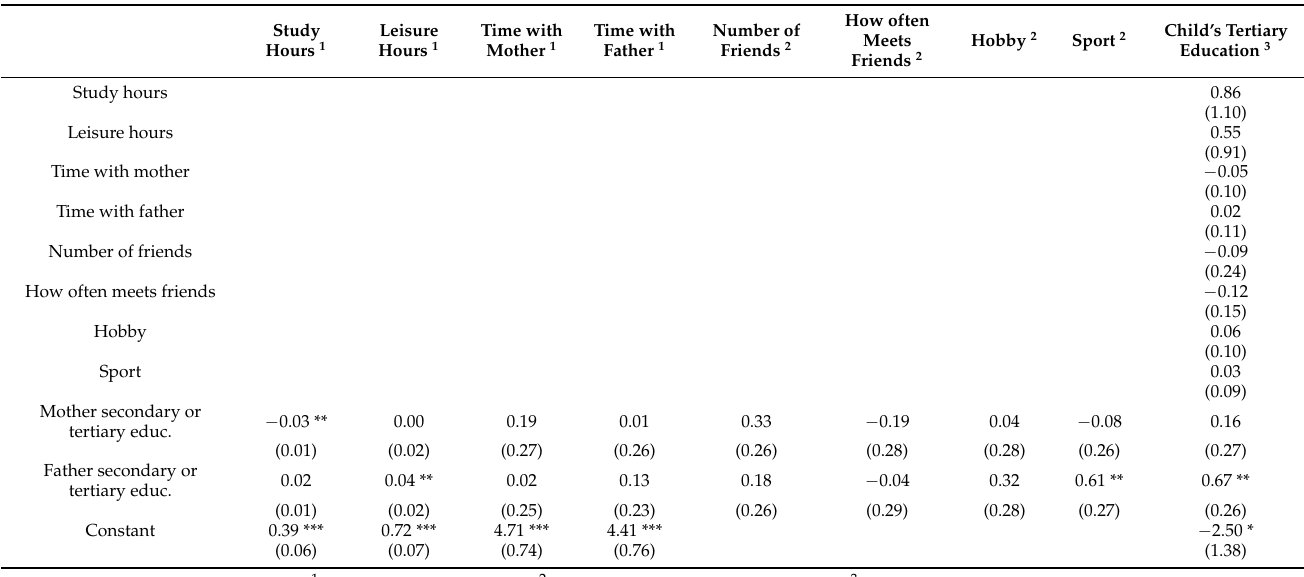
Mother secondary or tertiary